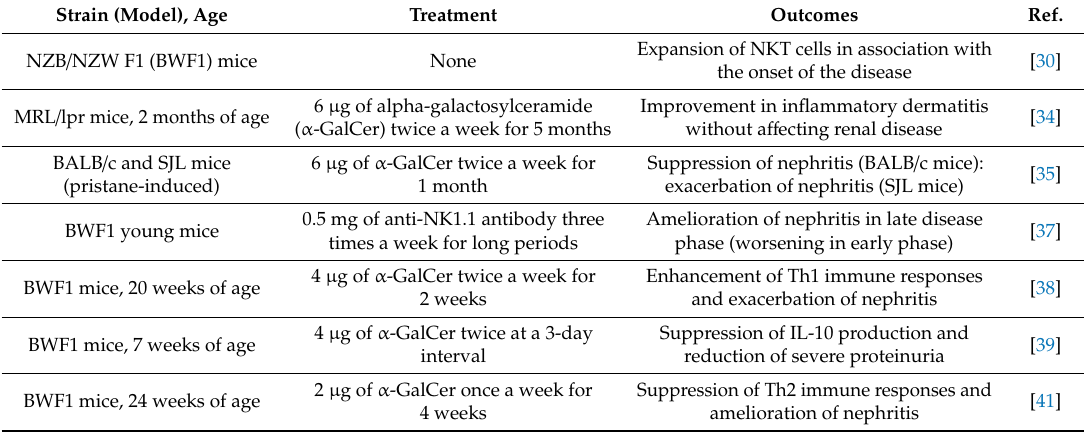
Table 2. Role of natural killer T cells in mouse models of systemic lupus erythematosus. Strain (Model), Age Treatment Outcomes